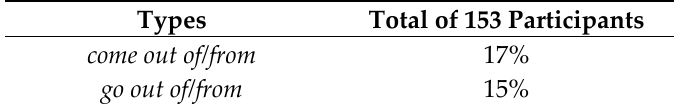
Table 6. Total deictic perspectives ( come vs. go ) in the frog-leaves-jar scene.